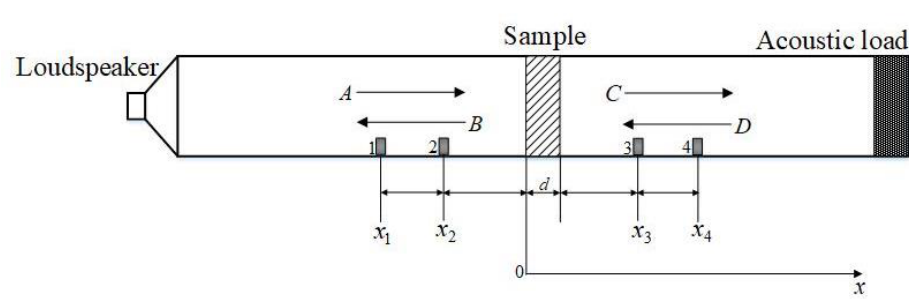
Figure 1. Four hydrophone measurement